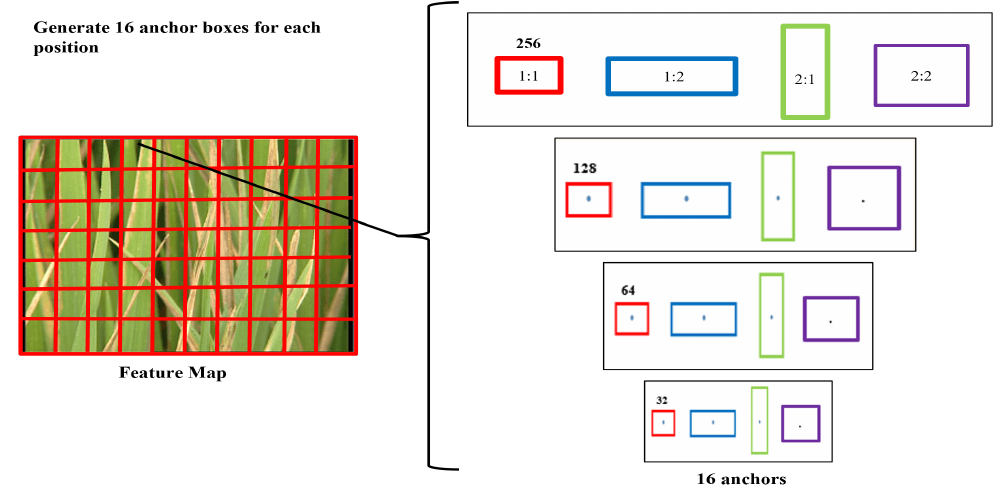
Figure 4. Sixteen anchor boxes with different scales generated for each sliding window position in the feature